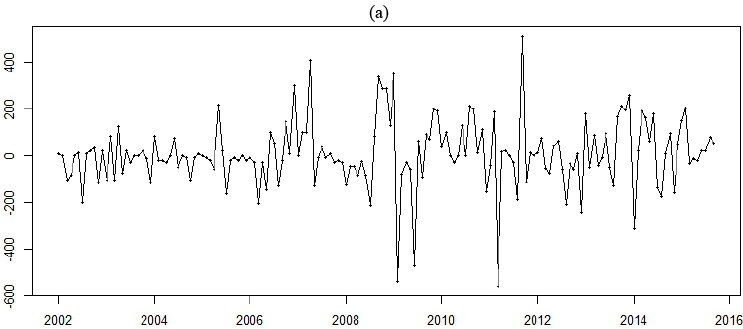
Figure 8. Residuals and their autocorrelations in sugi ARIMA model: ( a ) Plot of residuals; ( b ) autocorrelations with lags of up to 36 for the sugi log prices; ( c ) partial autocorrelations with lags of up to 36 for the sugi log prices.